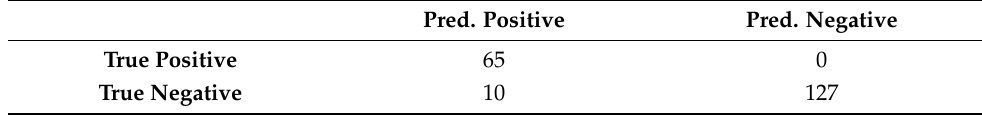
Table 6. Confusion matrix for the entire testing set: CNN Xception.